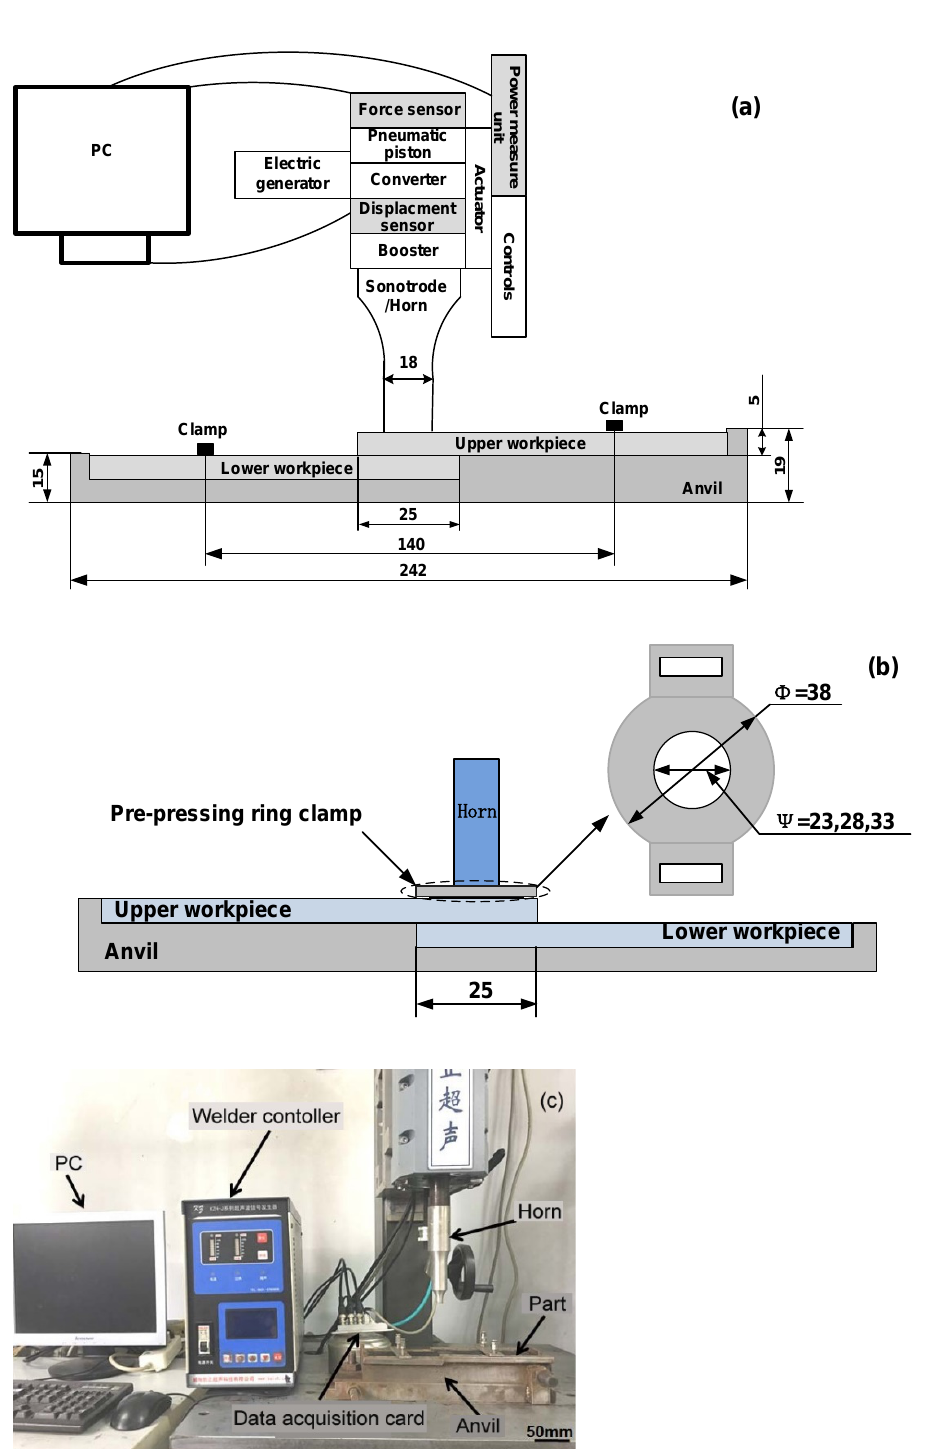
Figure 1. Schematic of ultrasonic welding of injection molded 4 mm thick lapped Cf/PA6 composite without energy director: ( a ) normal UW; ( b ) with PPRC; ( c ) Ultrasonic welder (Dimensions in mm).